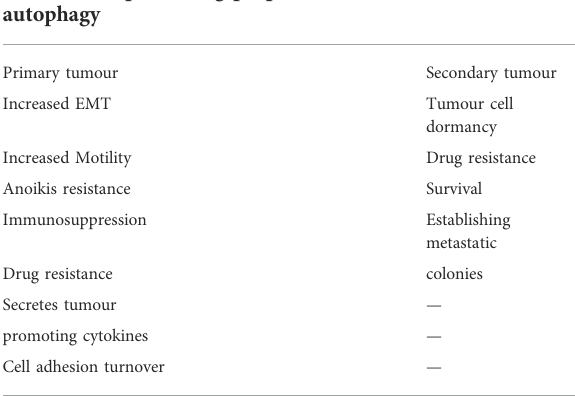
TABLE 1 The tumour promoting properties of